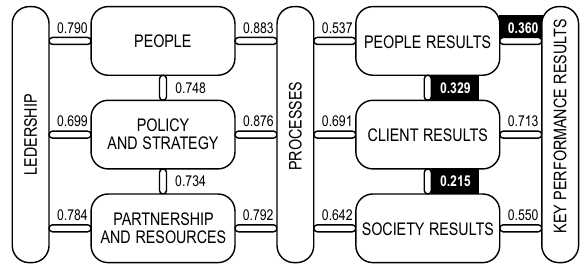
Fig. 6. Correlation coefficients for the consultants Note: the numbers in black shadings show lower correlations between the criteria.